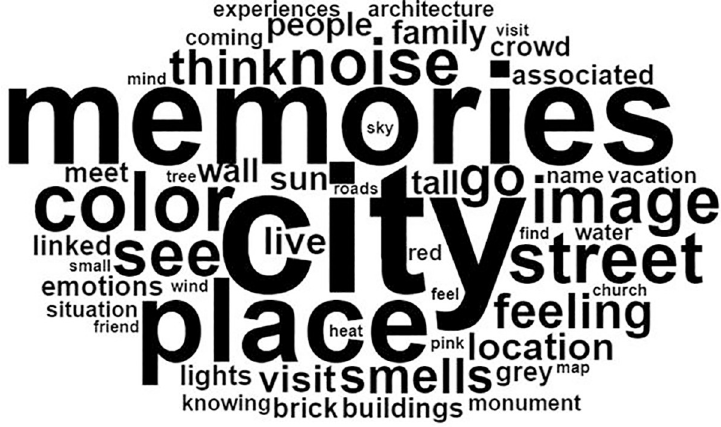
Fig 2. Word cloud for the control group (the original French word cloud is available in supplementary data) .